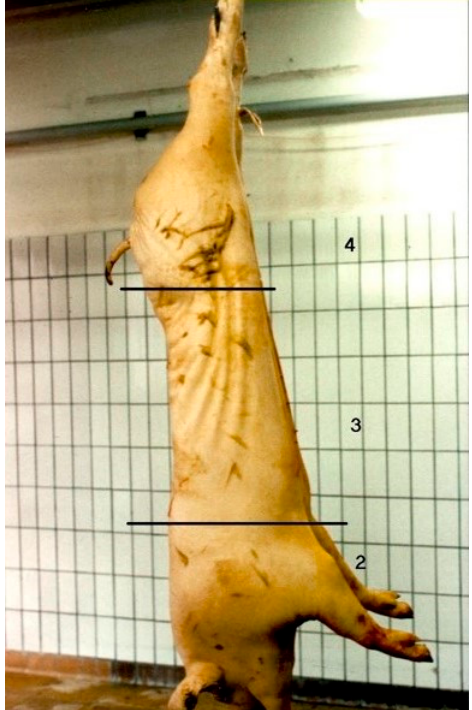
Figure 2. Scoring skin damage per part of the carcass, i.e., shoulder, middle and ham, starting at score 1 = no damage and 4 = extreme damage [14]. The lesions shows brown because this picture was made after singeing in contrast with the used skin damage scoring technique which was before singeing.